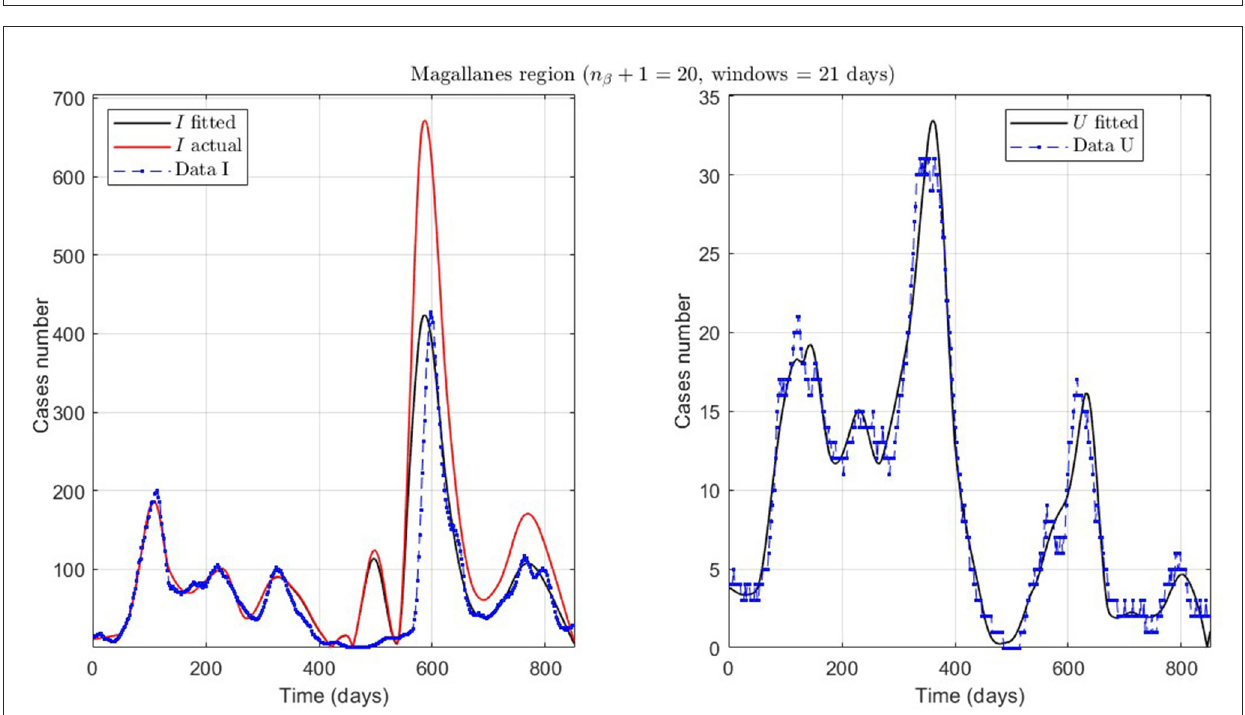
240 (unrestricted immunity duration). (A, B) 7 November 2020 to 8 October 2022; 4 =